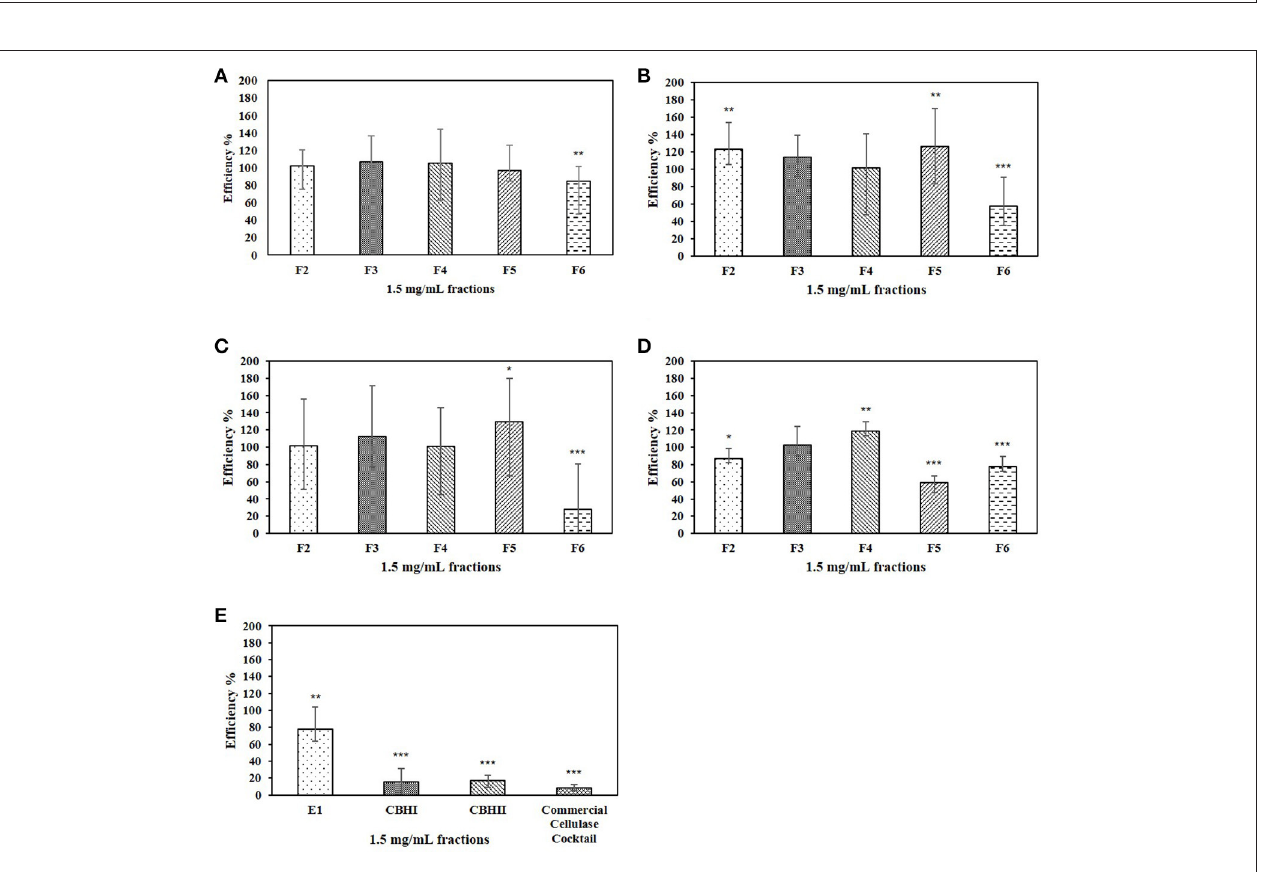
Frontiers in Bioengineering and Biotechnology | www.frontiersin.org